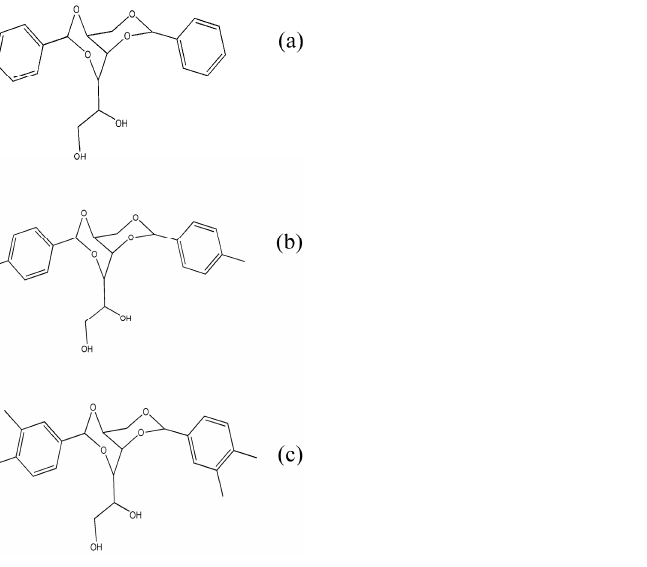
Figure 1. Sorbitol molecules used in this work: ( a ) DBS, ( b ) MDBS, and ( c ) DMDBS.